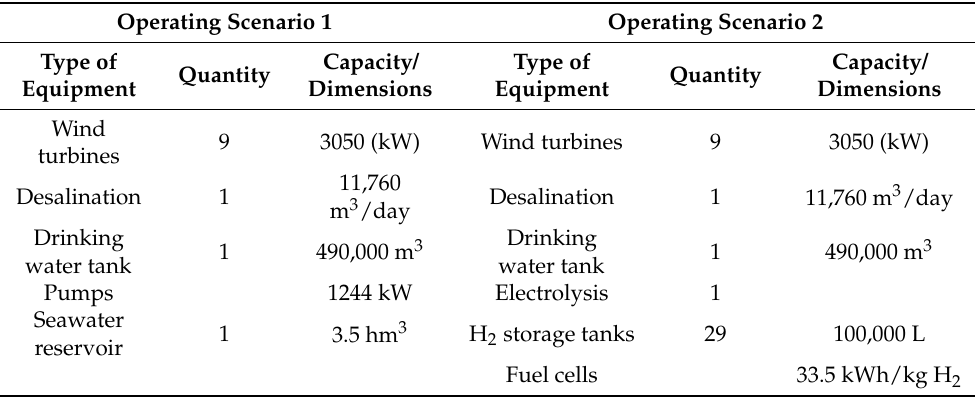
Table 3. Basic elements of operating scenarios 1 and